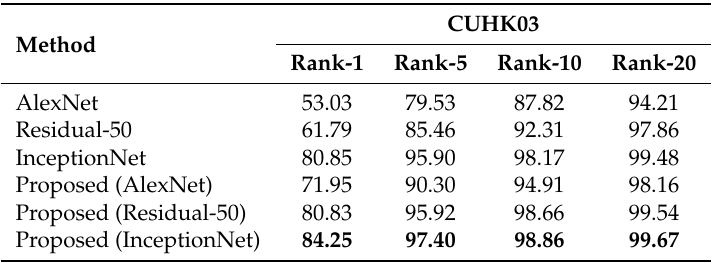
Table 2. Comparison with the three base networks, AlexNet, Residual-50 and InceptionNet on CUHK03 (by adopting the proposed DJL-S structure) in terms of identification accuracy (%).